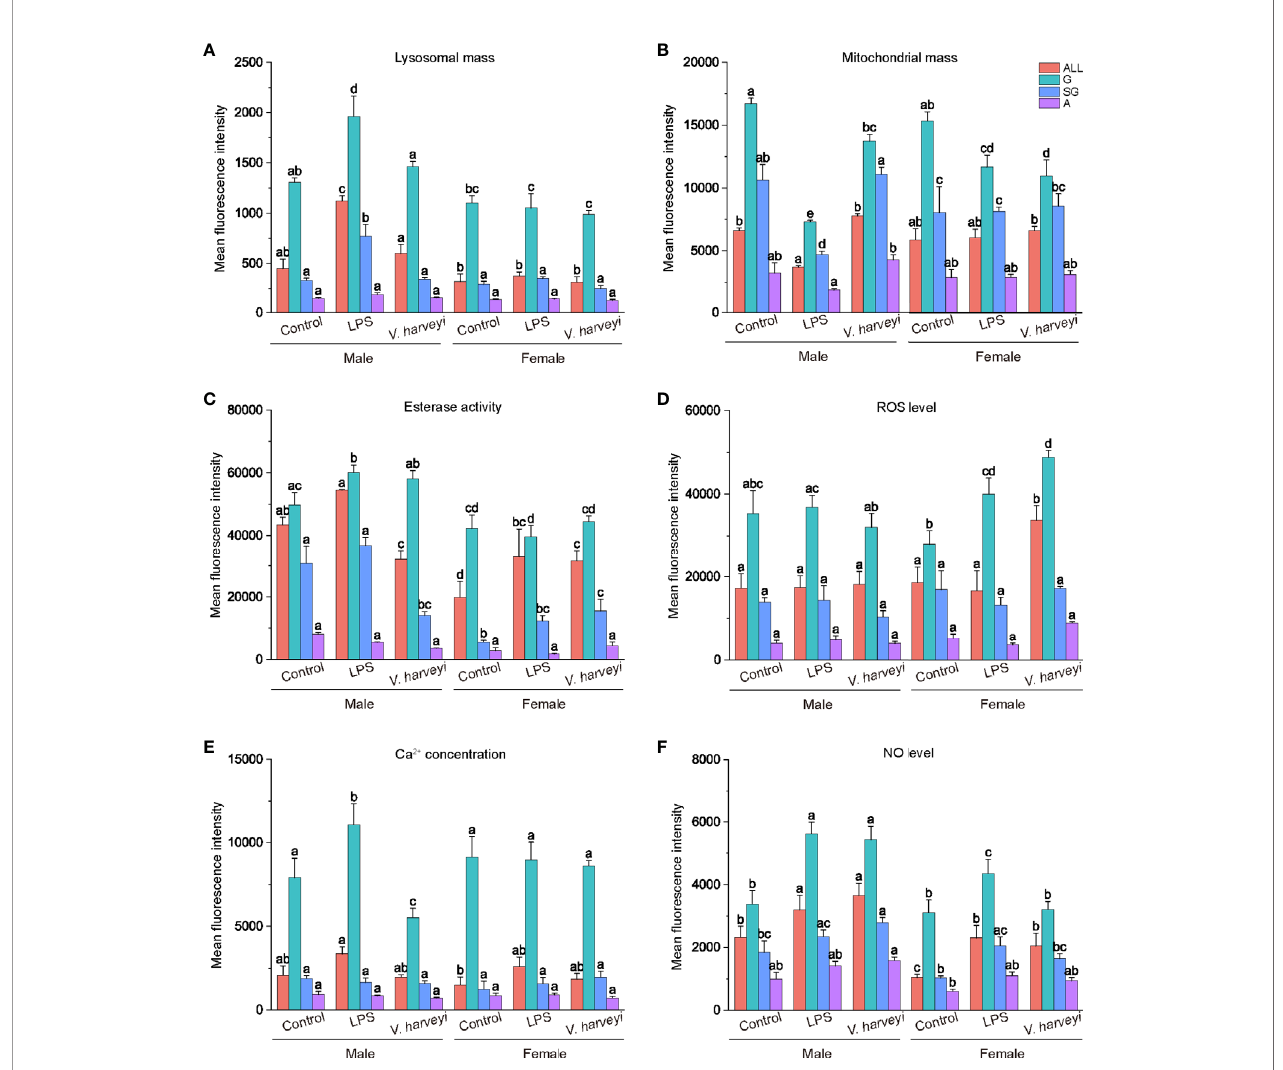
FIGURE 6 | Immunological characteristics of all hemocyte subpopulations after stimulation. (A) lysosomal mass, (B) mitochondrial mass, (C) esterase activity, (D) ROS level, (E) intracellular calcium concentration, (F) NO level. The means denoted by different letters for each fi xed hemocyte subpopulation are signi fi cantly different among the different stimulations ( p < 0.05). G, granulocytes; SG, semi-granulocytes; A,